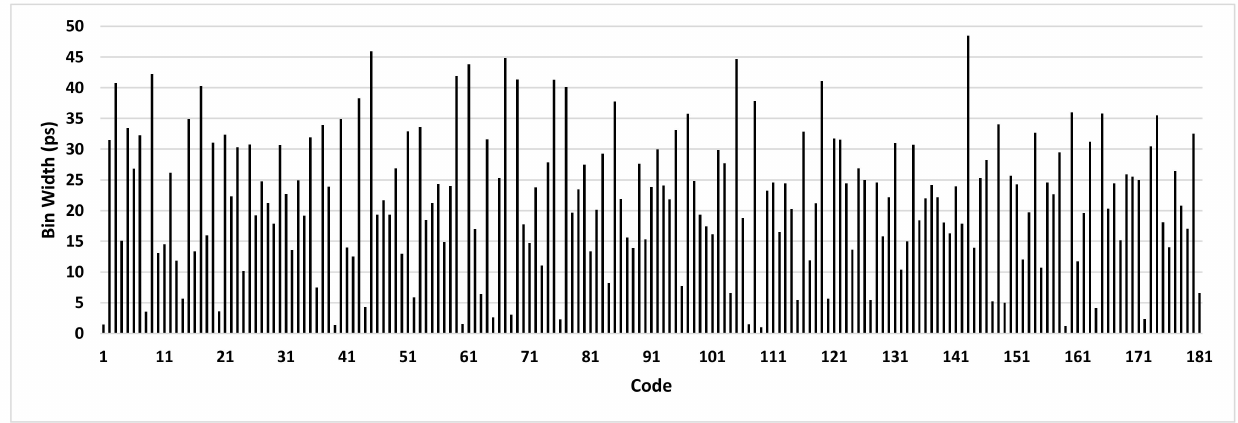
Figure 5. Measured bin widths of a TDC with “SCSS” sampling pattern resulted from code density